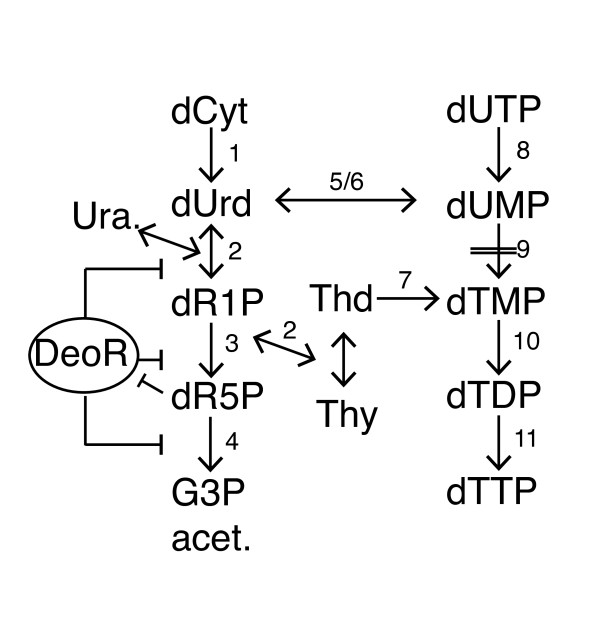
Schematics of a pyrimidine salvage pathway. Model of deoxyribose nucleotide salvage pathway. Double dashed line indicates block in a pathway due to gene deletion or in case of pathway 9 (dUMP → dTMP), block in pathway due to starvation of cells for essential cofactor tetrahydrofolate (not shown) by TMP treatment. Thymine and thymidine represent external metabolites transported from the media. Genes associated with pathways: 1 - cdd; 2 - deoA; 3 - deoB; 4 - deoC; 5 - tdk; 6 - yjjG; 7 - tdk; 8 - nudI/dut; 9 - thyA; 10 - tmk; 11 - ndk. Abbreviations: dCyt: deoxycytidine; dUrd.: deoxyuridine; Ura. - uracil; dR1P - deoxyribose-1-phosphate; dR5P: deoxyribose-5-phosphate; G3P/acet.: glyceraldehyde-3-phophate/acetaldehyde; Thd - thymidine (external); Thy - thymine (external).